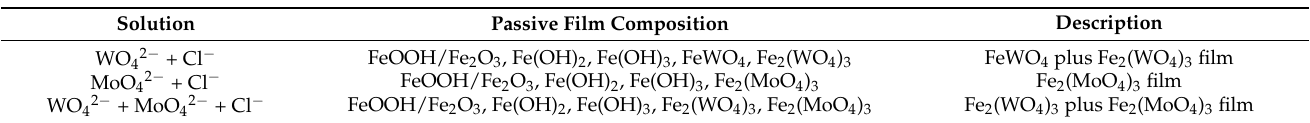
Table 3. Composition of the passive film on Q235 carbon steel surface formed in WO 42 − + Cl − , MoO 42 − + Cl − and WO 42 − + MoO 42 − + Cl − solutions.